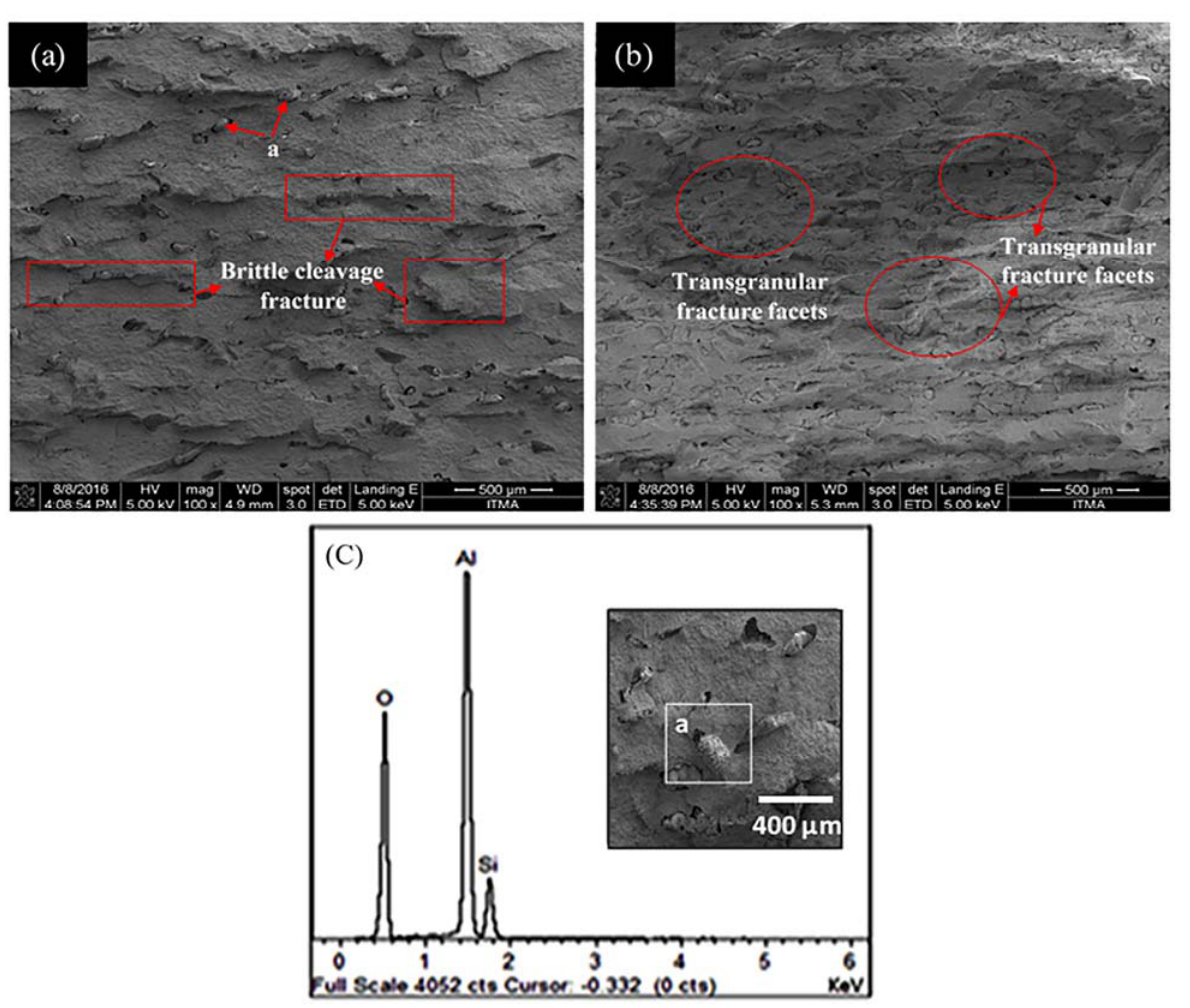
Figure 7. FESEM microstructures of fracture surfaces of ( a ) Al 2 O 3 - 63–125 RH 5 , ( b ) Al 2 O 3 - 63–125 RH 15 , and ( c ) EDS spectrum of spot A.